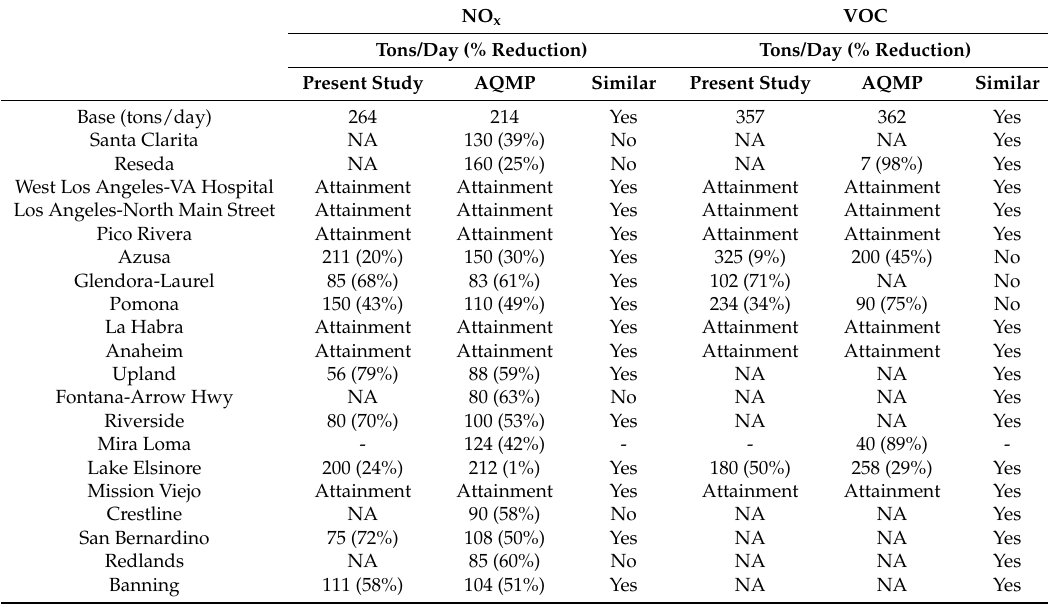
Table 5. NO x and VOC levels required to achieve future-year (2030 for this study and 2031 for the AQMP) 70 ppb ozone design values at various monitors in the SoCAB. The monitor groups are ordered from east to west with monitors in each group ordered from north to south. NA means not achievable. For this paper, the two studies are considered similar when the differences between the reductions required to achieve attainment are within